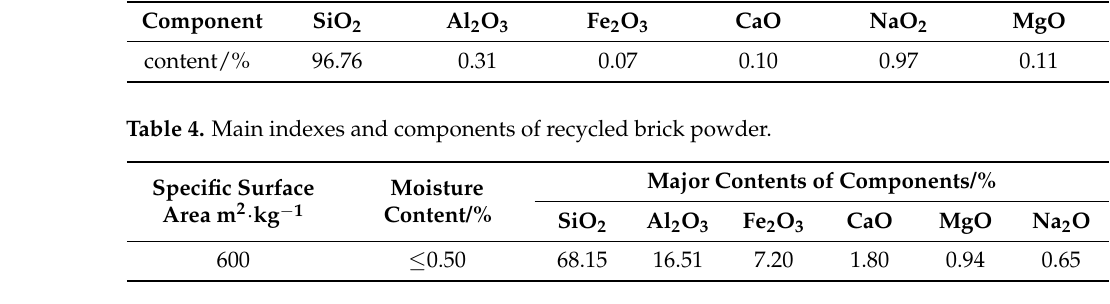
Table 5. Main technical indexes of steel fiber.